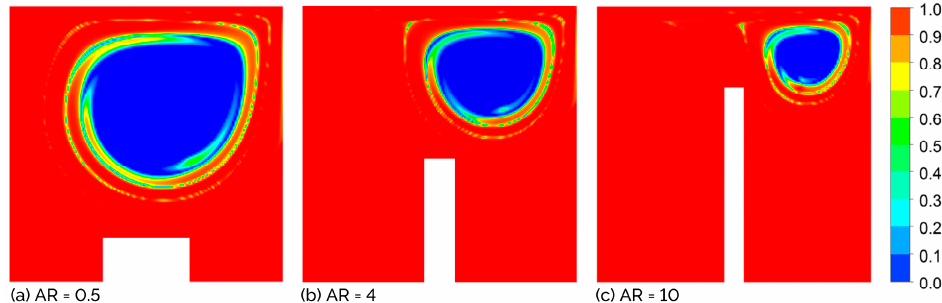
Figure 11. Contour plots of Bejan number for Ra = 10 5 , Re = 1000, and fin area fraction of 0.05 for three fin aspect ratios. ( a ) AR = 0.5, ( b ) AR = 4, and ( c ) AR = 10.